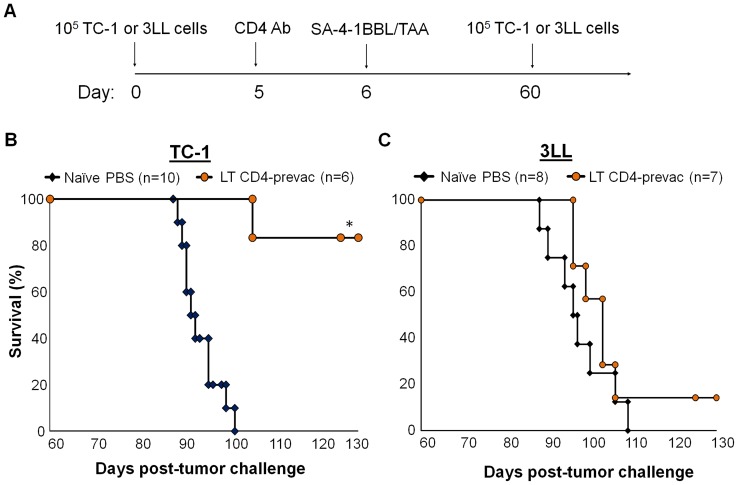
CD4+ T cells are required for SA-4-1BBL/TAAs vaccine-induced long-term immune memory against 3LL, but not against TC-1 tumor.(A) Schematic depiction of the experimental procedure. (B) Long-term C57BL/6 mice that had eradicated TC-1 tumors irrespective of CD4+ T cell depletion one day before vaccination with SA-4-1BBL/E7 had long-term protective immune response as assessed by a secondary challenge with TC-1 tumor cells 60 days after the initial tumor inoculation. Naïve mice injected with PBS and challenged with 1×105 TC-1 cells served as controls and expired from tumor burden within 40 days. (C) Long-term C57BL/6 mice that had eradicated 3LL tumors irrespective of CD4+ T cell depletion one day before vaccination with SA-4-1BBL/SVN had significantly compromised memory immune response as assessed by a secondary challenge with 3LL tumor cells 60 days after the initial tumor inoculation. Naïve mice injected with PBS and challenged with 1×105 3LL cells served as controls and expired from tumor burden within 50 days.